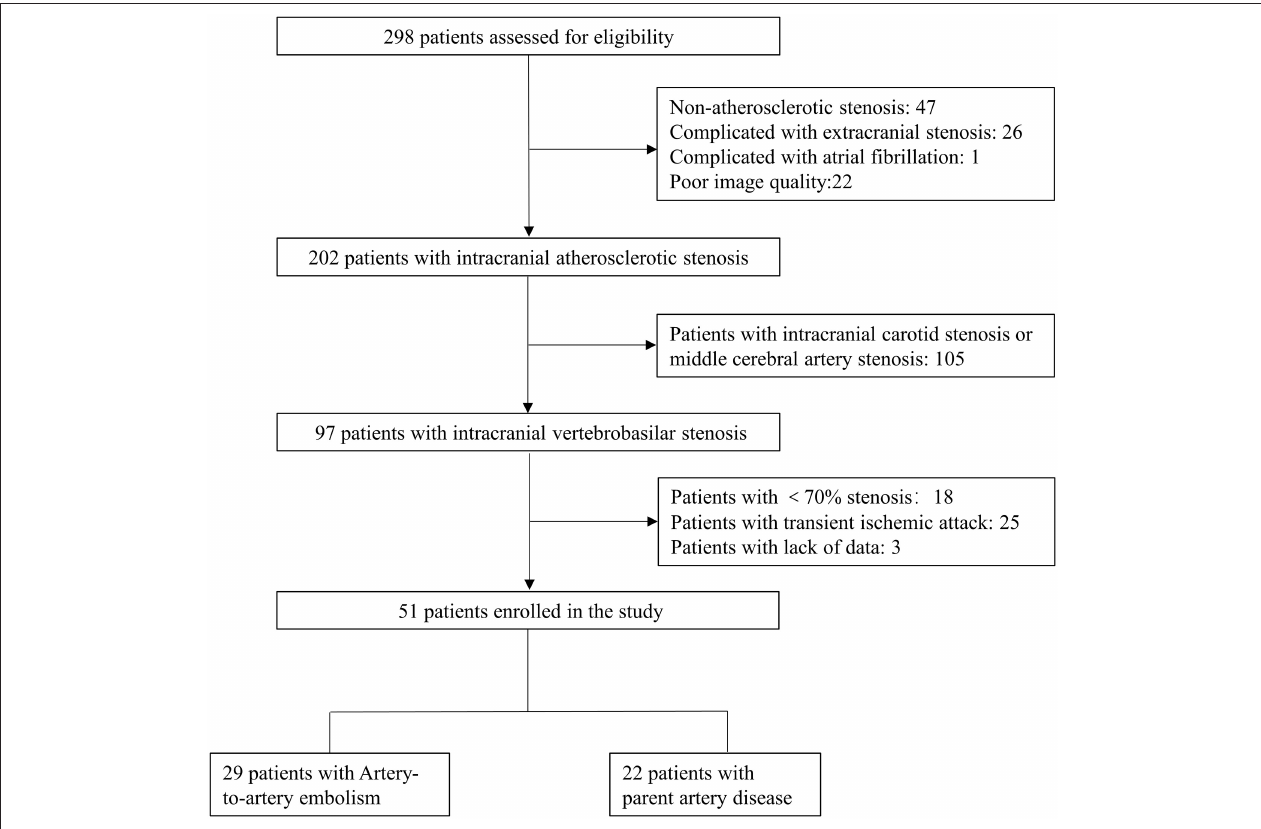
FIGURE 1 | Flow chart of the